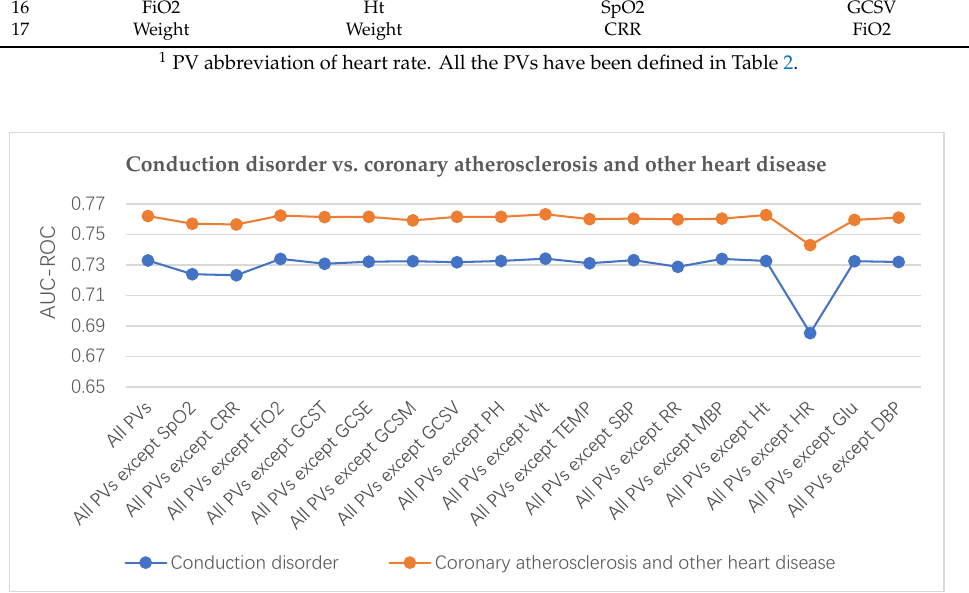
Figure 5. Ranking the importance of PVs (conduction disorder vs. coronary atherosclerosis and other heart diseases).